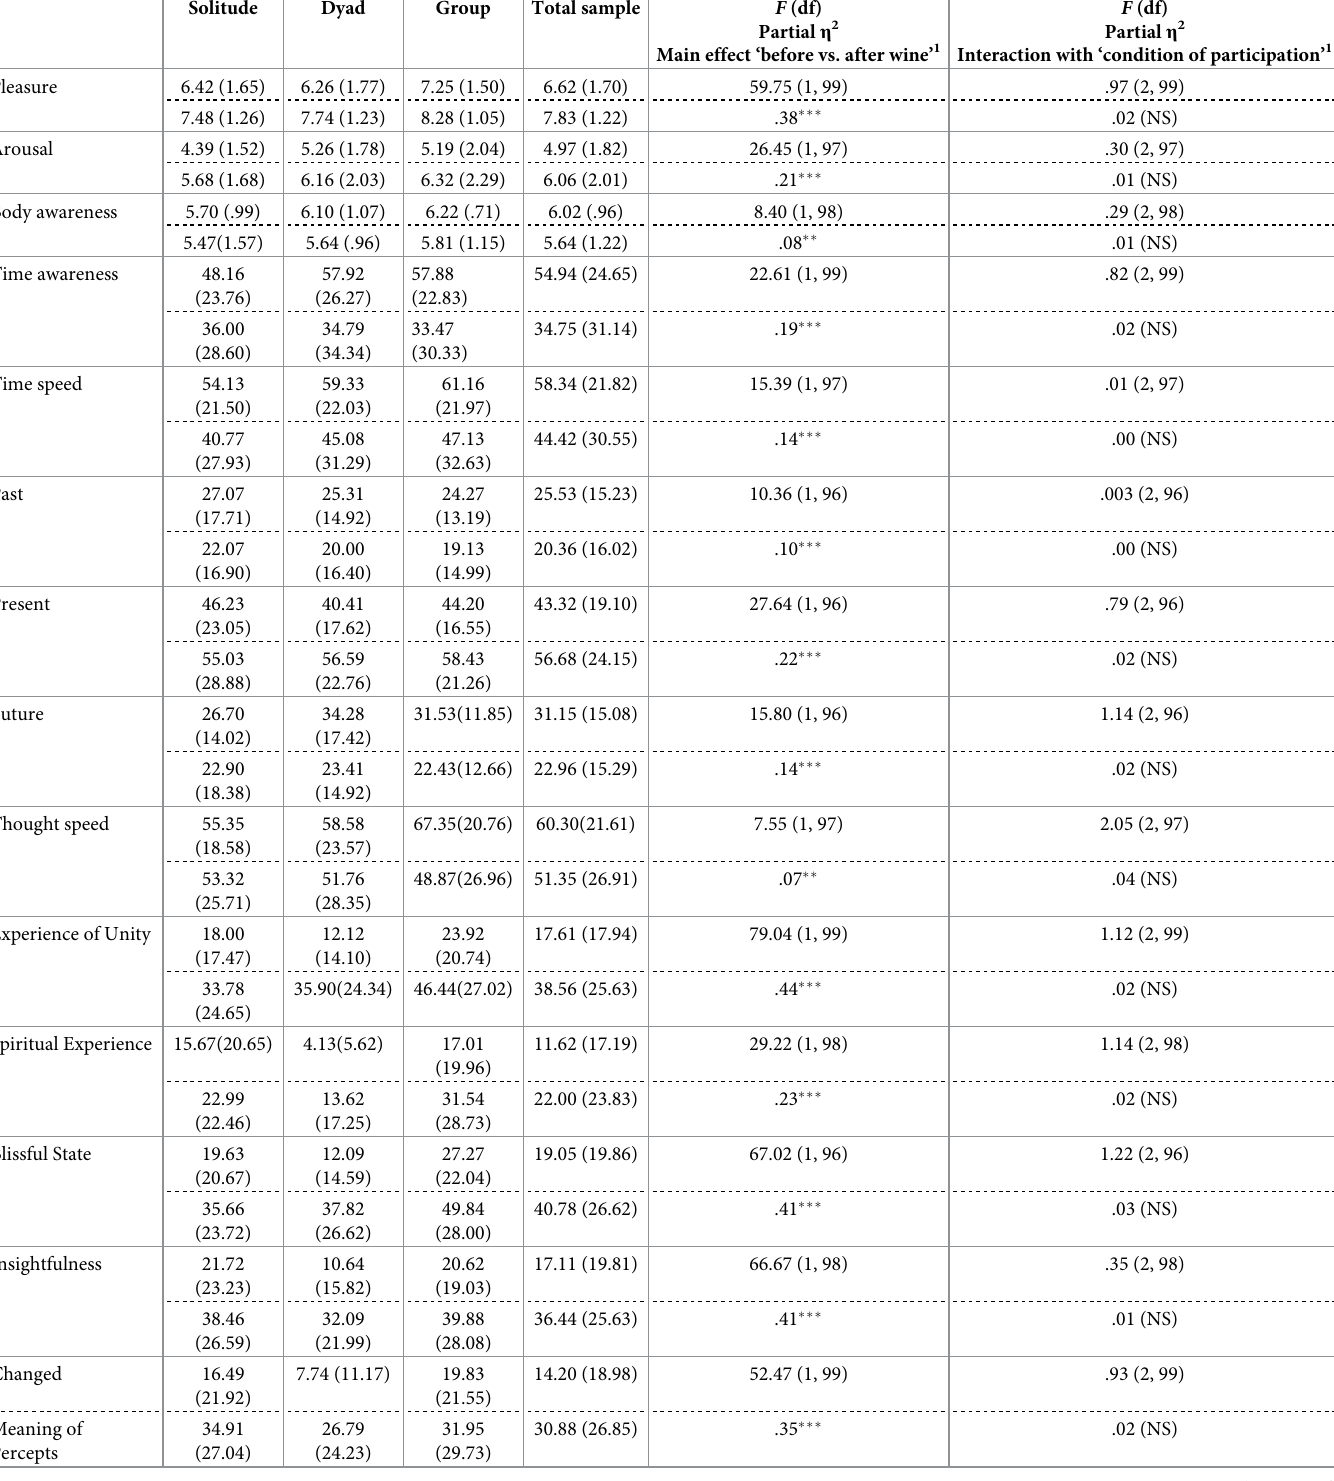
Table 3. Effects of red wine on